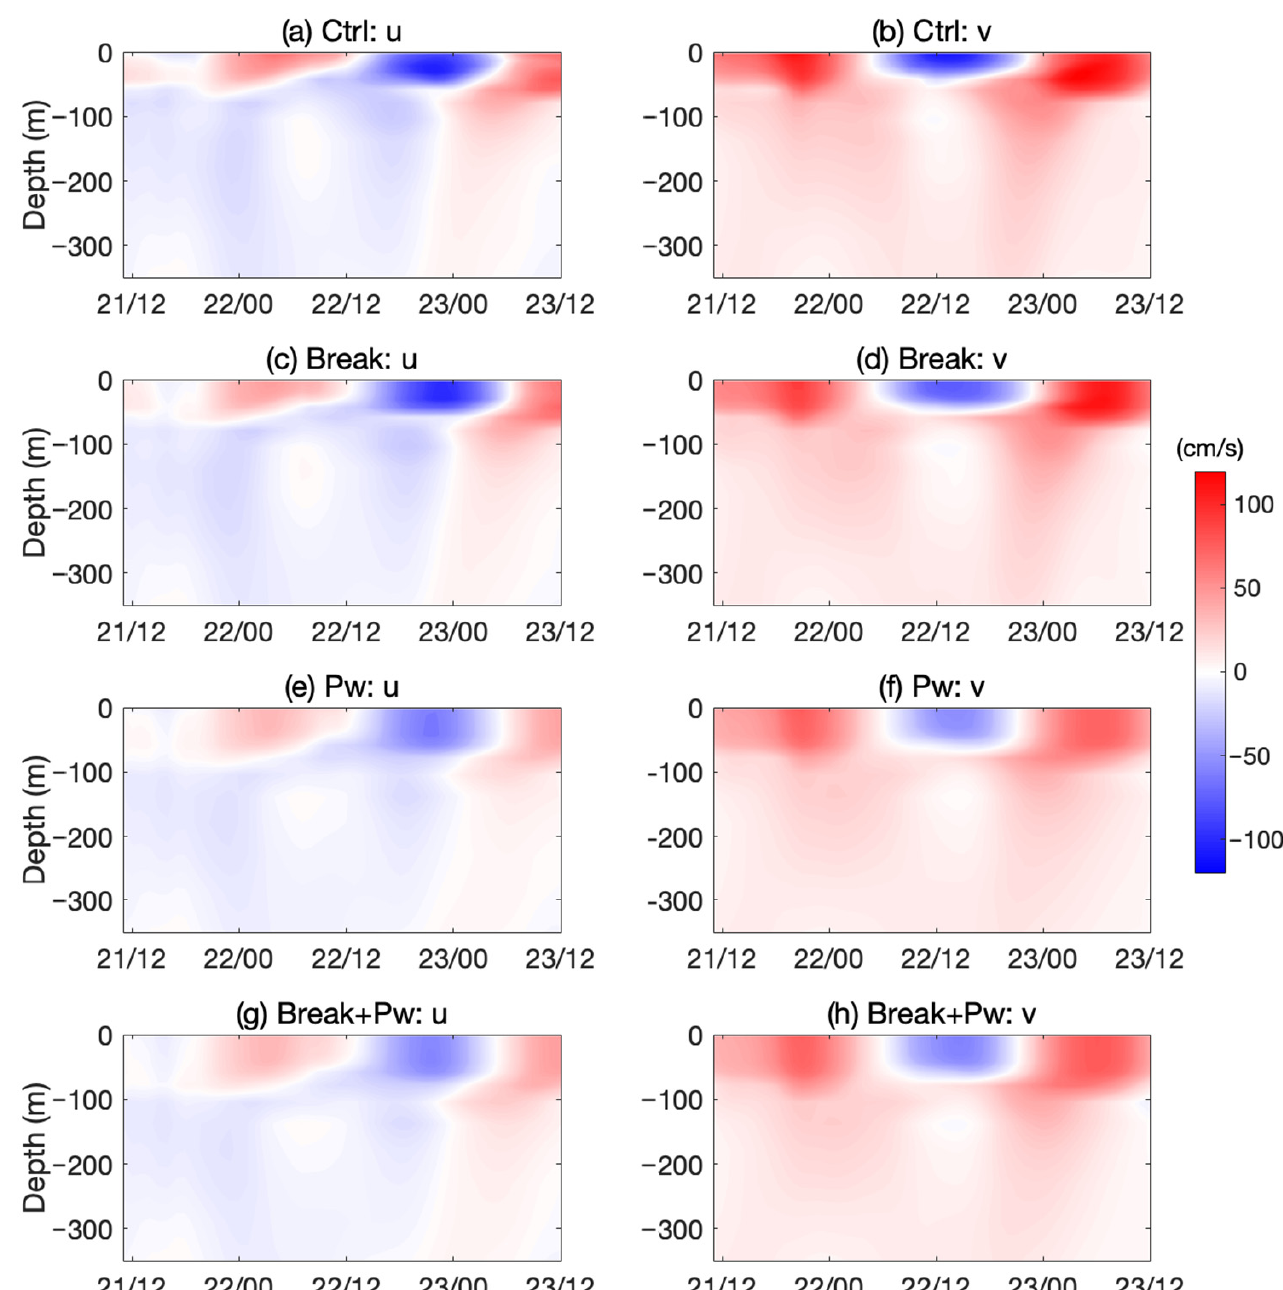
Figure 9. Same as Figure 8, but at the location of the right mooring.